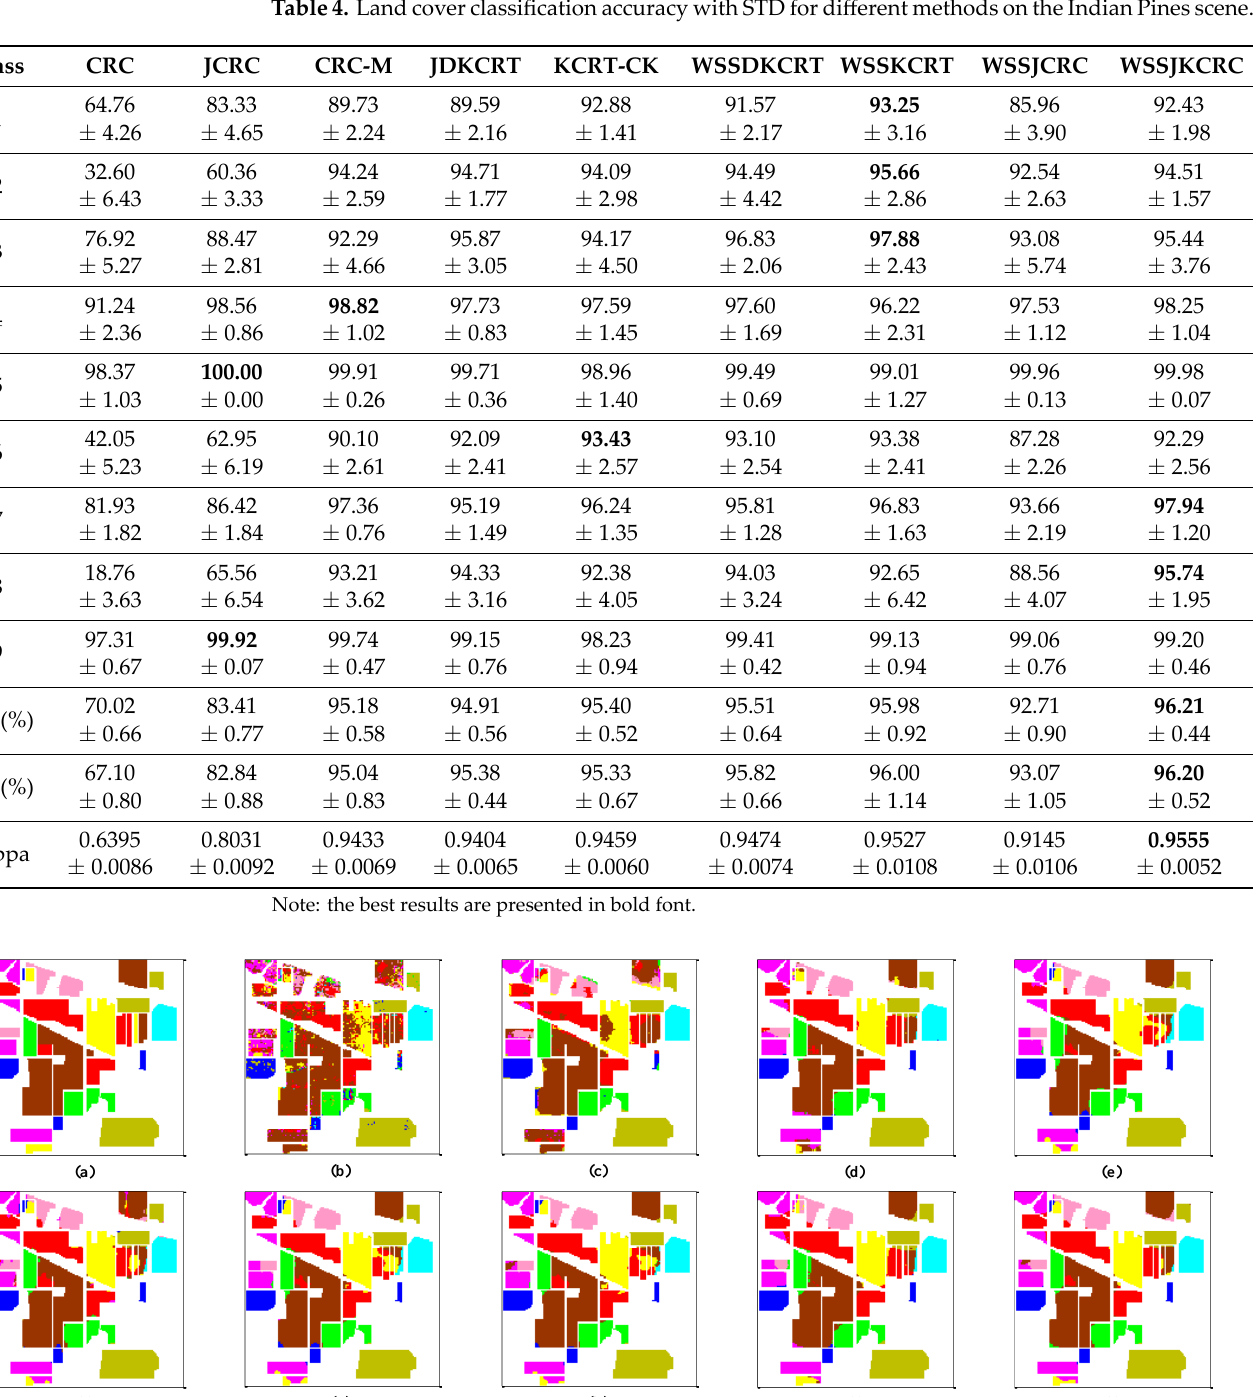
Table 4. Land cover classification accuracy with STD for different methods on the Indian Pines scene.